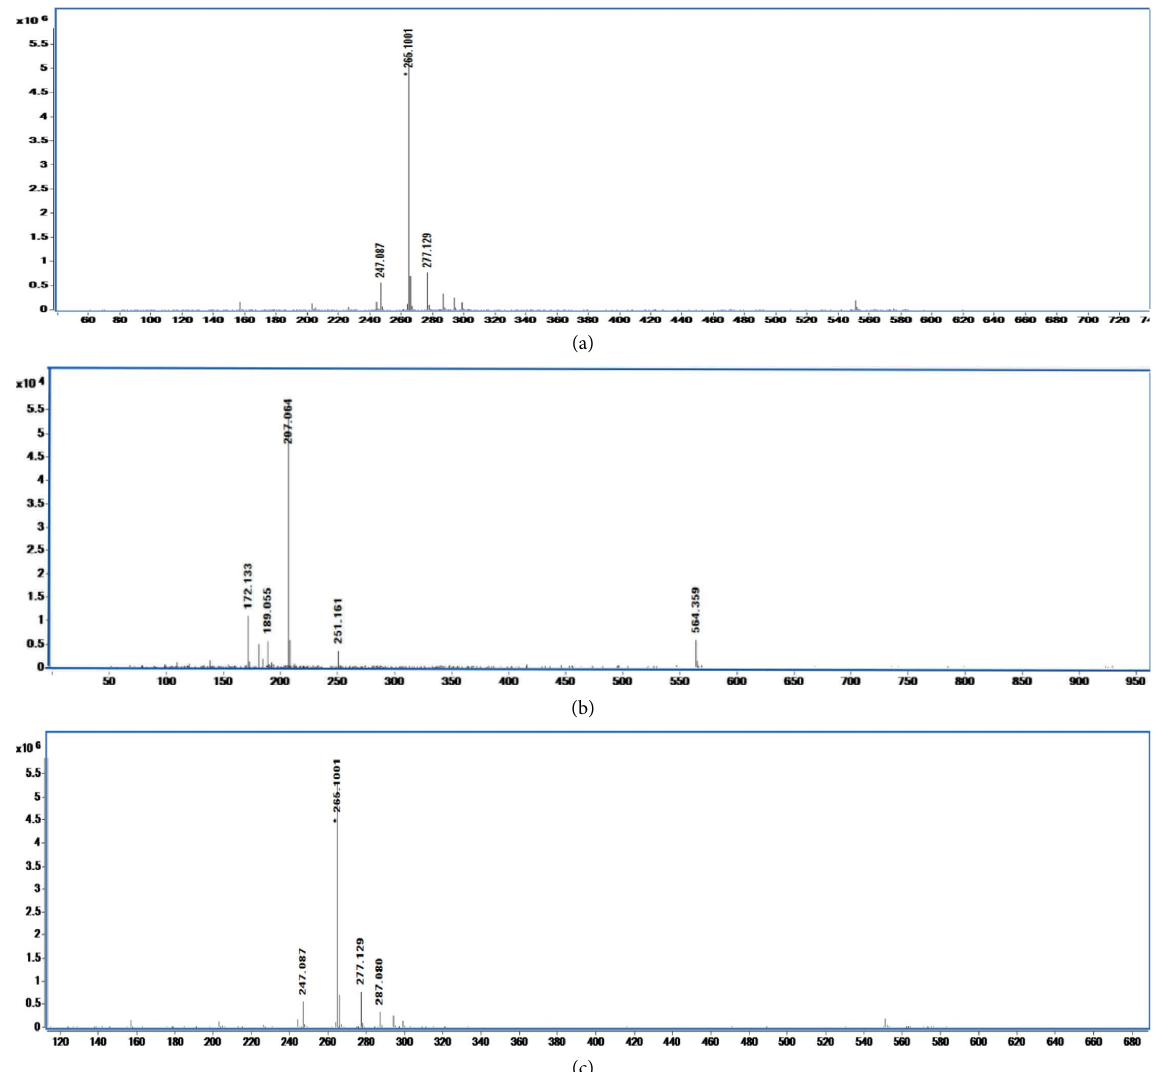
Figure 6: MS/MS spectra of 13 C FLU (a), MS/MS spectra of metabolites m / z 207 (b), and MS/MS spectra of metabolites m / z 247 (c) (abscissa: counts vs. mass-to-charge m / z ; ordinate: